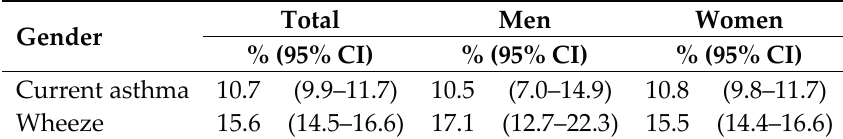
Table 3. Prevalence of current asthma and